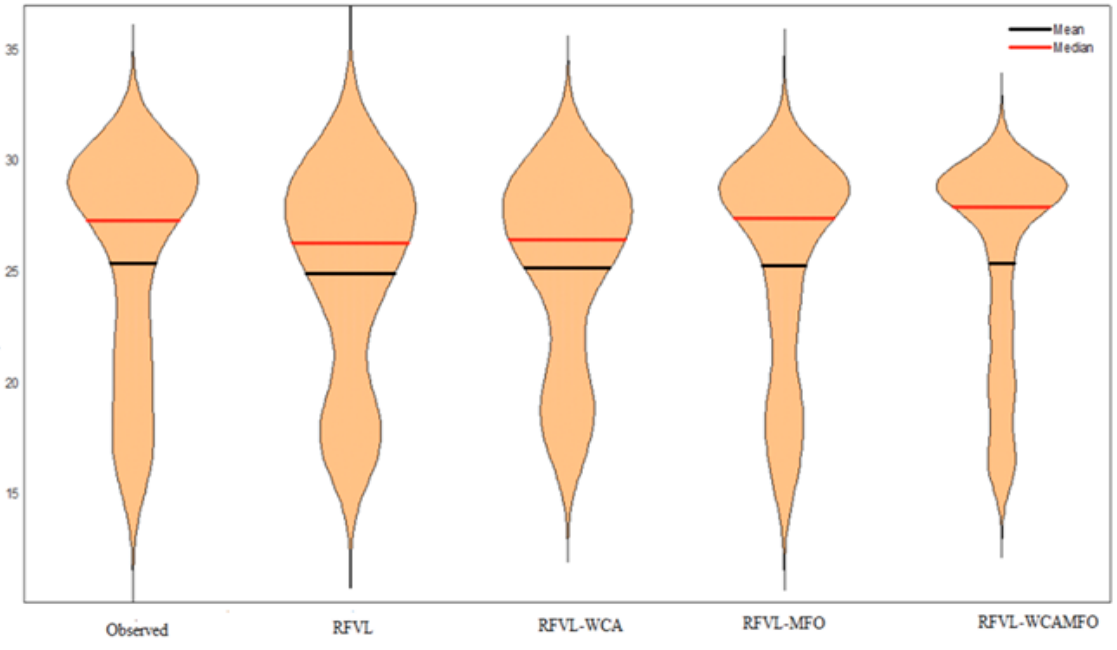
Figure 6. Violin Charts estimated temperature by different RVFL-based models in the test period for monthly time scale.